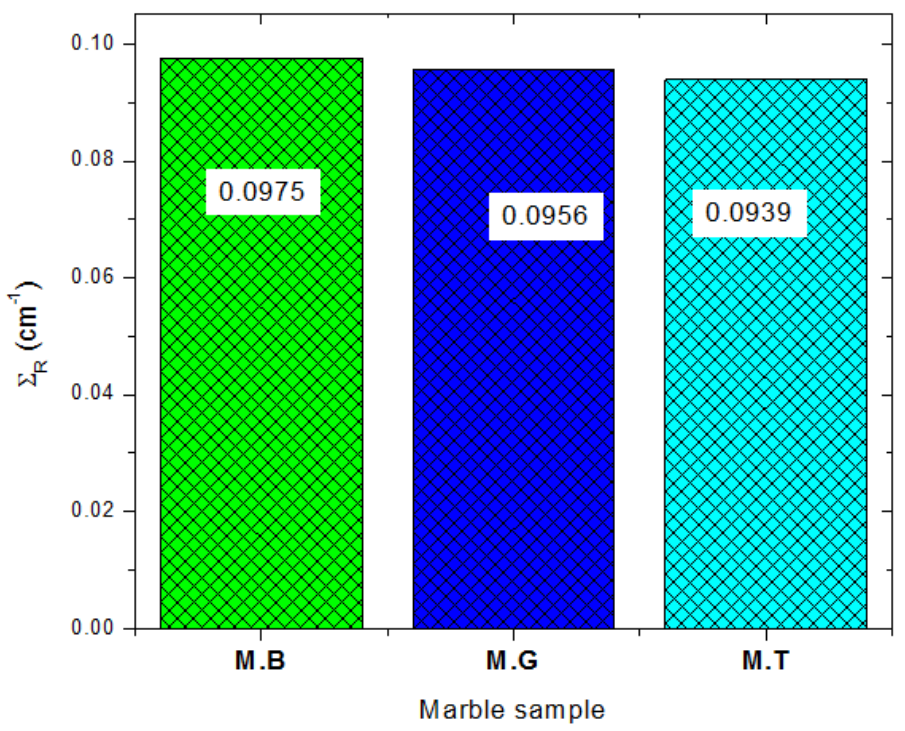
Figure 10. Effective removal for fast neutrons of the marble samples.